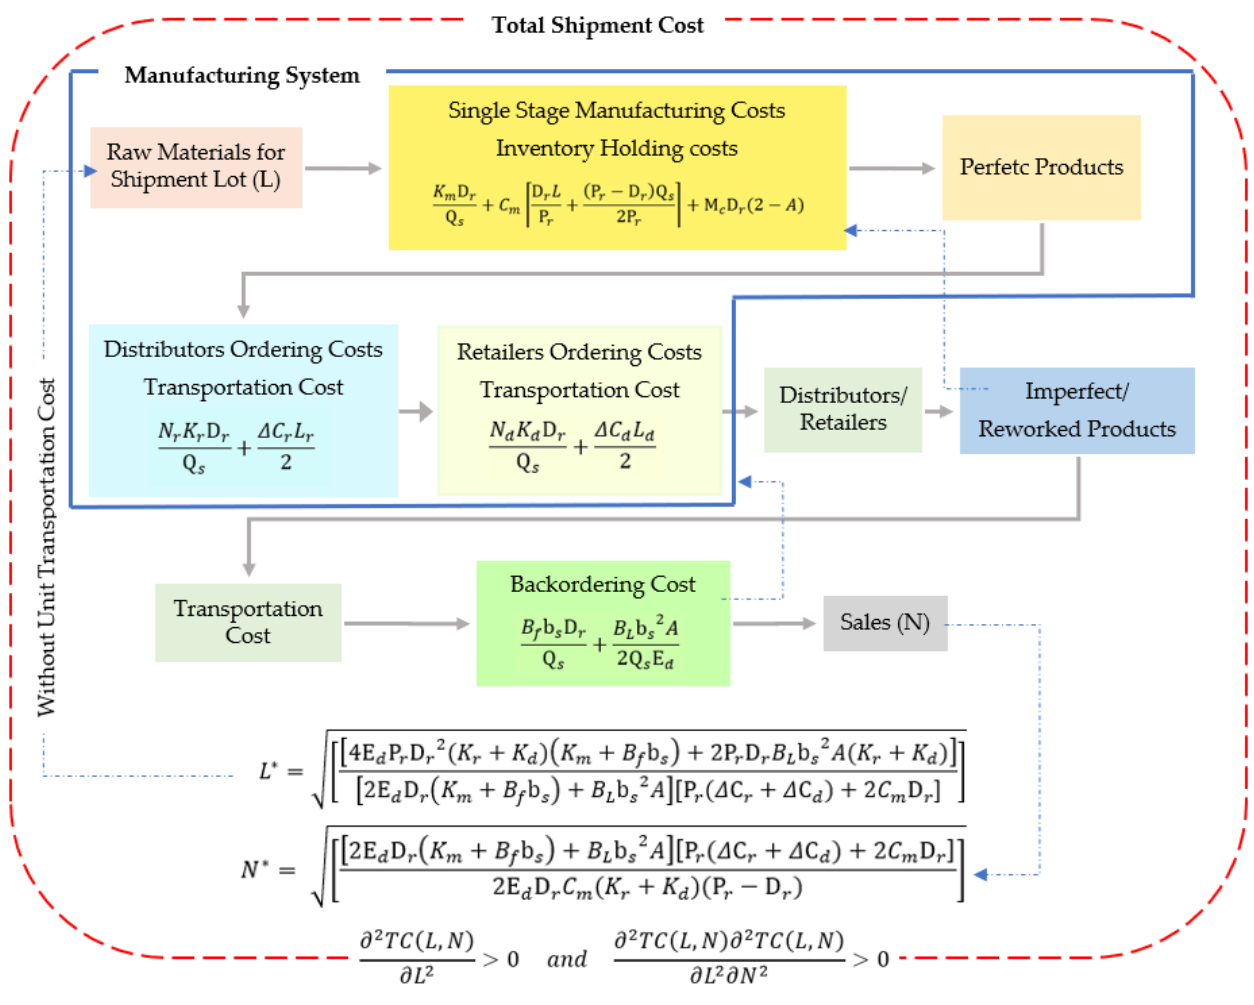
Figure 2. Modified EOQ model for optimized shipment in an imperfect production setup with transportation to distributor and retailer.